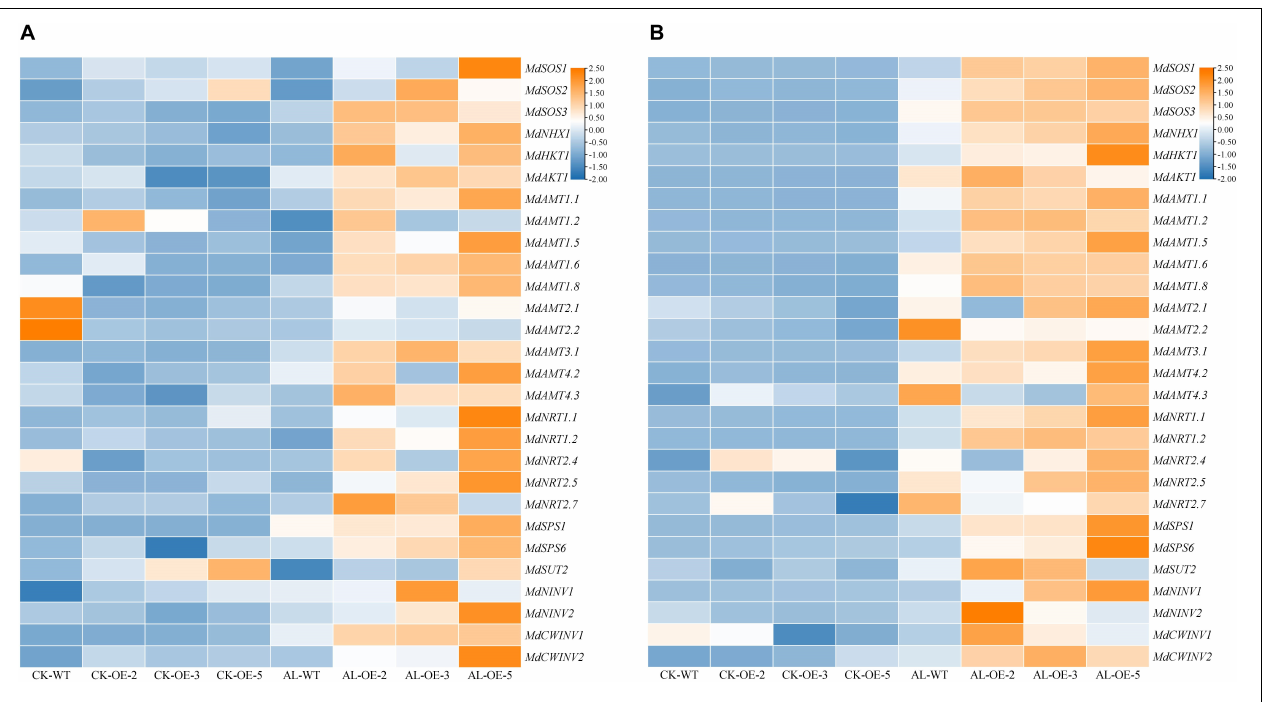
FIGURE 8 | Heatmap presenting expression levels of 6 ion-transport-related genes ( MdSOS1 , MdSOS2 , MdSOS3 , MdNHX1 , MdHKT1 , and MdAKT1 ), 15 N-absorption-related genes ( MdAMT1.1 , MdAMT1.2 , MdAMT1.5 , MdAMT1.6 , MdAMT1.8 , MdAMT2.1 , MdAMT2.2 , MdAMT3.1 , MdAMT4.2 , MdAMT4.3 , MdNRT1.1 , MdNRT1.2 , MdNRT2.4 , MdNRT2.5 , and MdNRT2.7 ) and 7 C-metabolism-related genes ( MdSPS1, MdSPS6 , MdSUT2 , MdNINV1, MdNINV2 , MdCWINV1 and MdCWINV2 ) in (A) leaves and (B) roots of MdTyDc -overexpressing apple plants after 15 days under control and alkaline conditions. The data